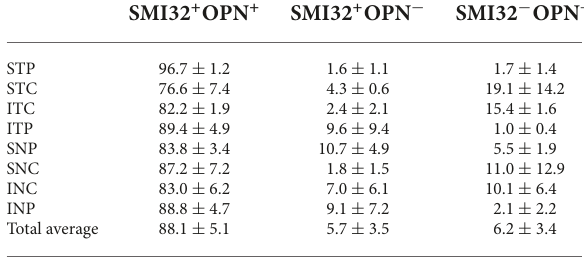
TABLE 2 Study of the percentage of RGCs expressing SMI32 + OPN + , SMI32 + OPN − or SMI32 − OPN + in each of the retinal regions studied. SMI32 + OPN + SMI32 + OPN − SMI32 − OPN